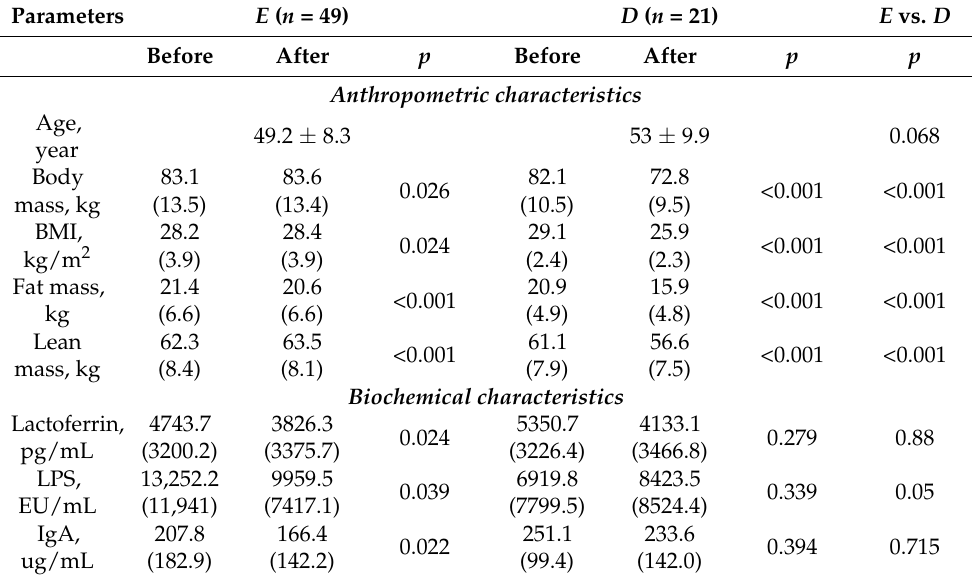
Table 2. Anthropometric and biochemical characteristics of the participants at baseline and subse- quent to the exercise and dietary